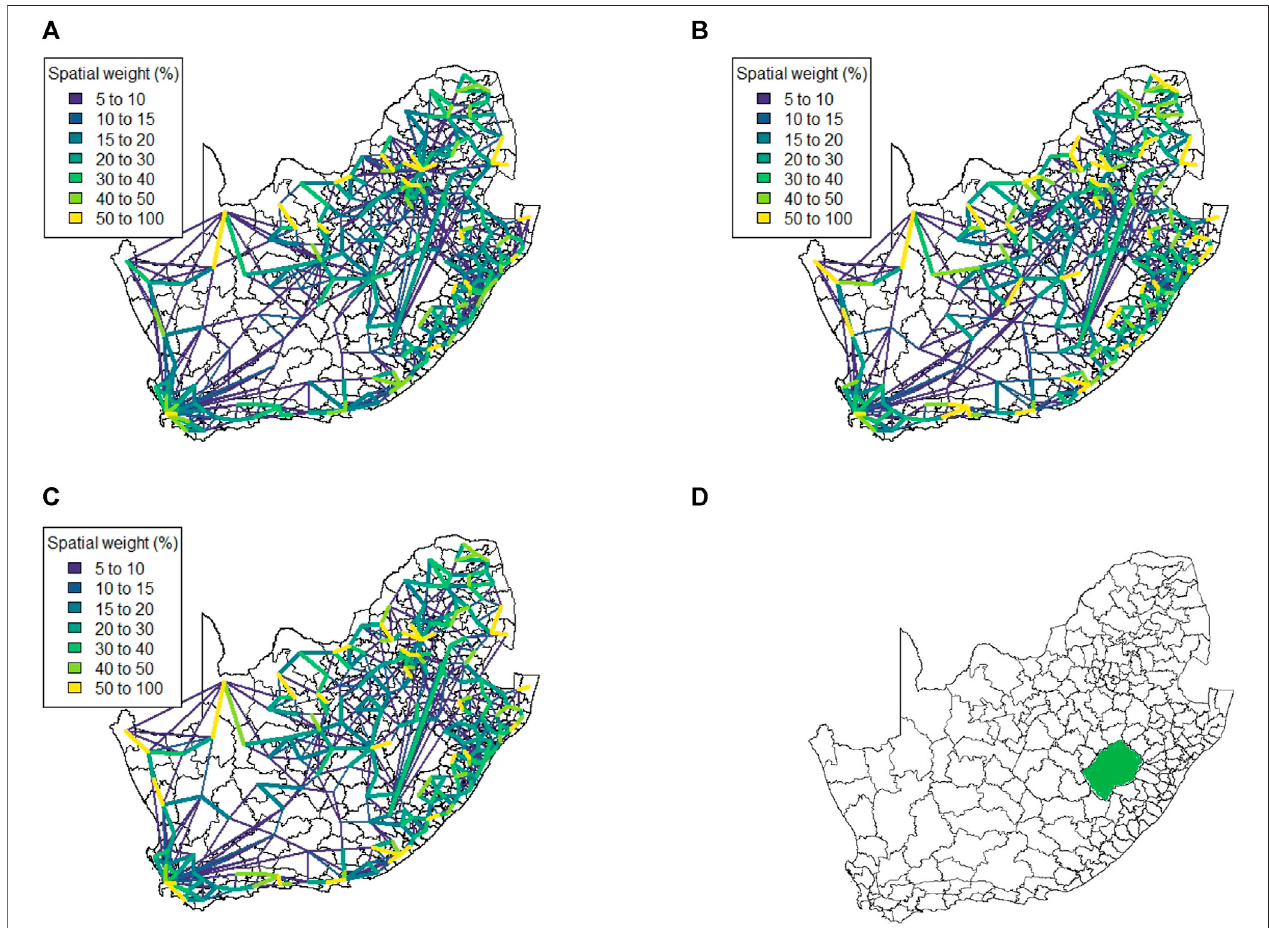
FIGURE 6| Method 2spatial weight matrix entries (weights ≤ 5not shown) (A) Business as usual, (B) Level 5, (C) Level 4, and (D) South Africa at local municipality level (neighboring country Lesotho in green).